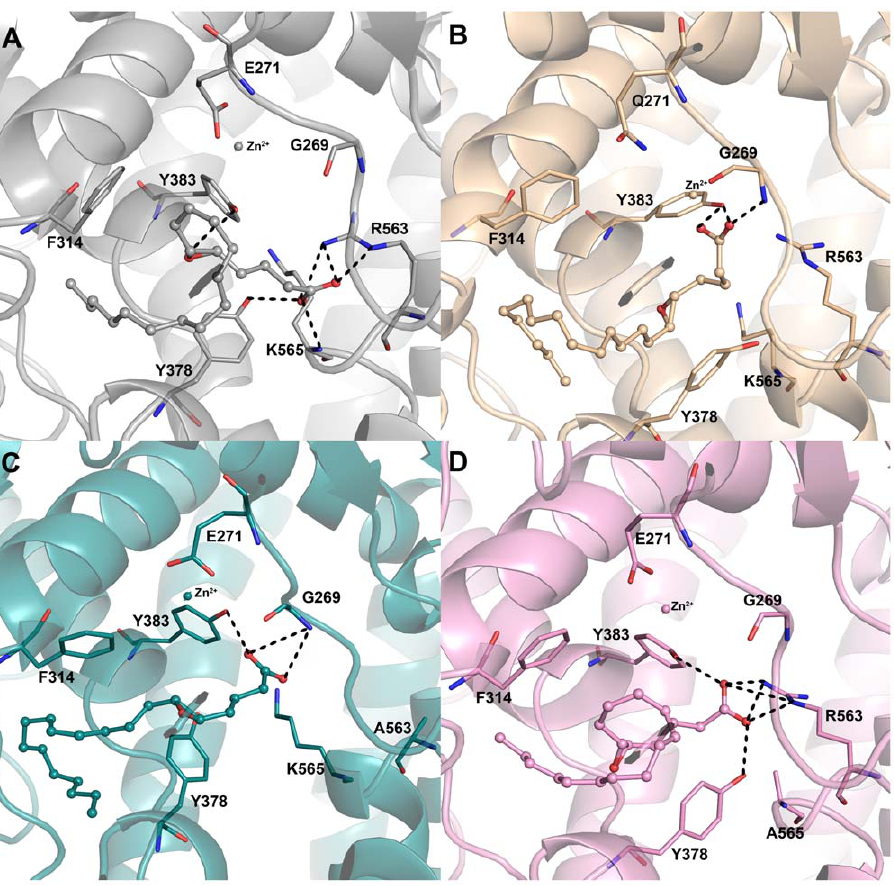
Figure 7. The binding modes of LTA4 at the active site of the enzyme in L-LTA4 systems. The binding mode of LTA4 in (A) WT (grey), (B) E271Q (wheat) (C) R563A (deep teal), and (D) K565A (pink) systems. The amino acid residues and LTA4 are shown in think stick and ball-stick forms, respectively. The metal ion (zinc) present at the active site is shown in sphere form.